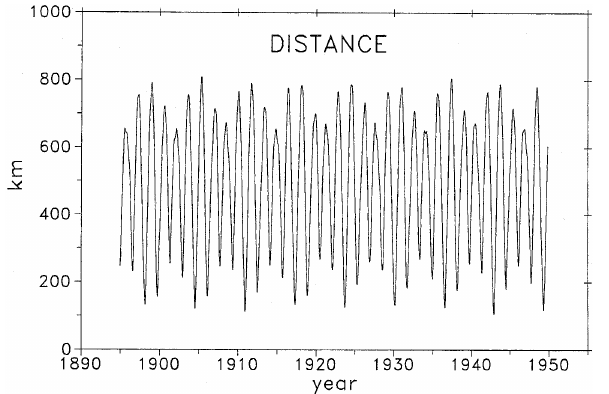
Fig. 4. The power spectrum of the periods in the distance of the centre of the Sun (computed for the time interval 1868–2030). Be- sides the dominant period of 1.6 years (584 days) (V-E), also the significant periods of 2.13 years (25.6 months) (E-Ma)), 1.0 years, of 0.91 years (332 days) (V-Ma), of 0.8 years (292 days) ((V-E)/2)) and 6.4 years, ... have been detected. All these periods are above 99% confidence level which is represented by the dashed horizontal line. The period of 1.3 years reaches up to 99% confidence level. The period of 2.13 years corresponds to a mean value of